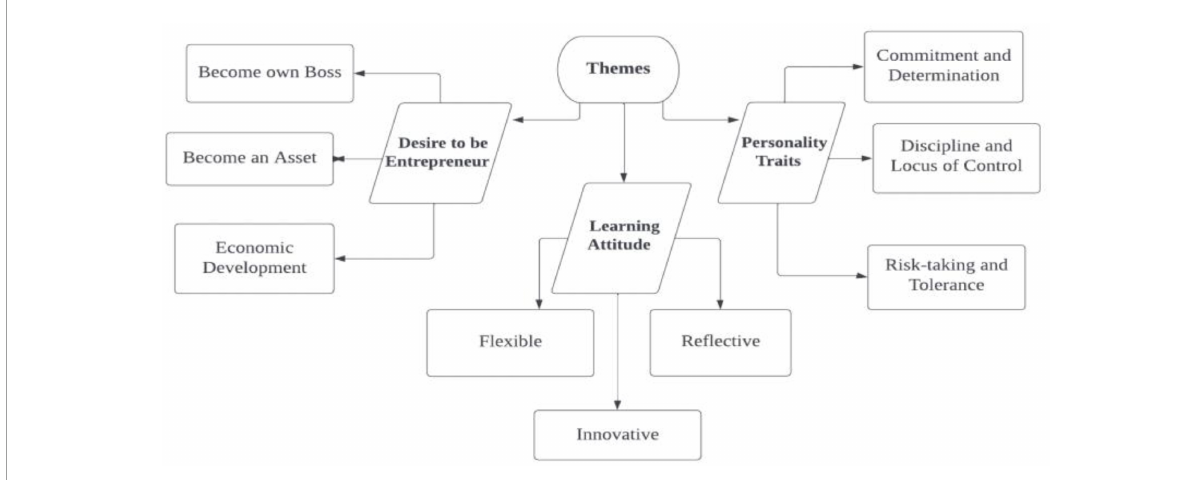
FIGURE1 Cumulative themes of entrepreneur